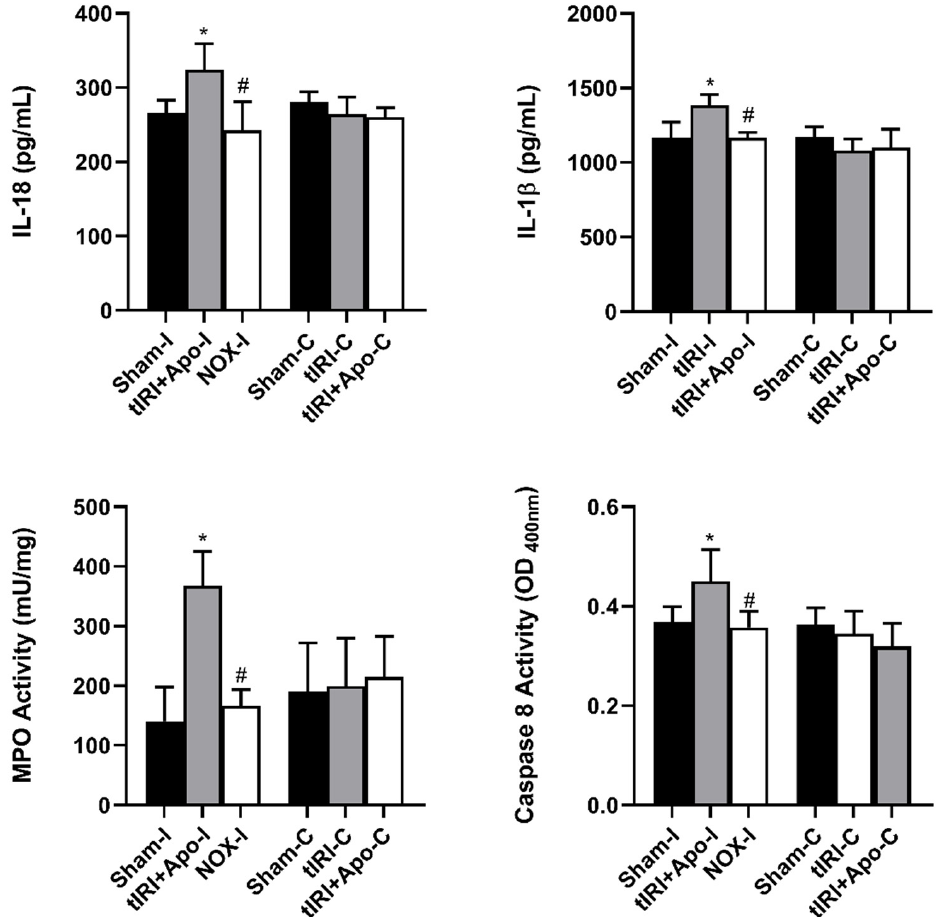
Figure 4. NOX-activated NLRP3 promotes male germ cell inflammatory response. The production of downstream inflammatory targets of NLRP3: caspase 8, IL-1 β , and IL-18, was determined by colorimetric assay and ELISA. Caspase 8 activity and cytokine concentrations were calculated following their manufacture’s respective protocols. The data were analyzed using one-way analysis of variance (ANOVA) followed by Holm-Sidak multiple comparisons test and presented as mean values ± SD ( n = 6/group). * tIRI compared to sham and # apocynin-treated compared to tIRI. Apo = Apocynin, I = Ipsilateral, C = Contralateral.